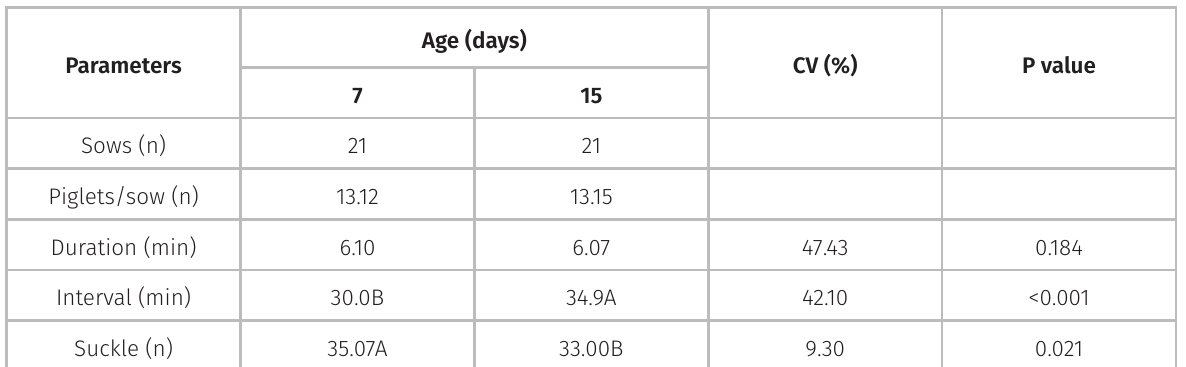
Table III. Behavior of suckling piglets according to age in days.